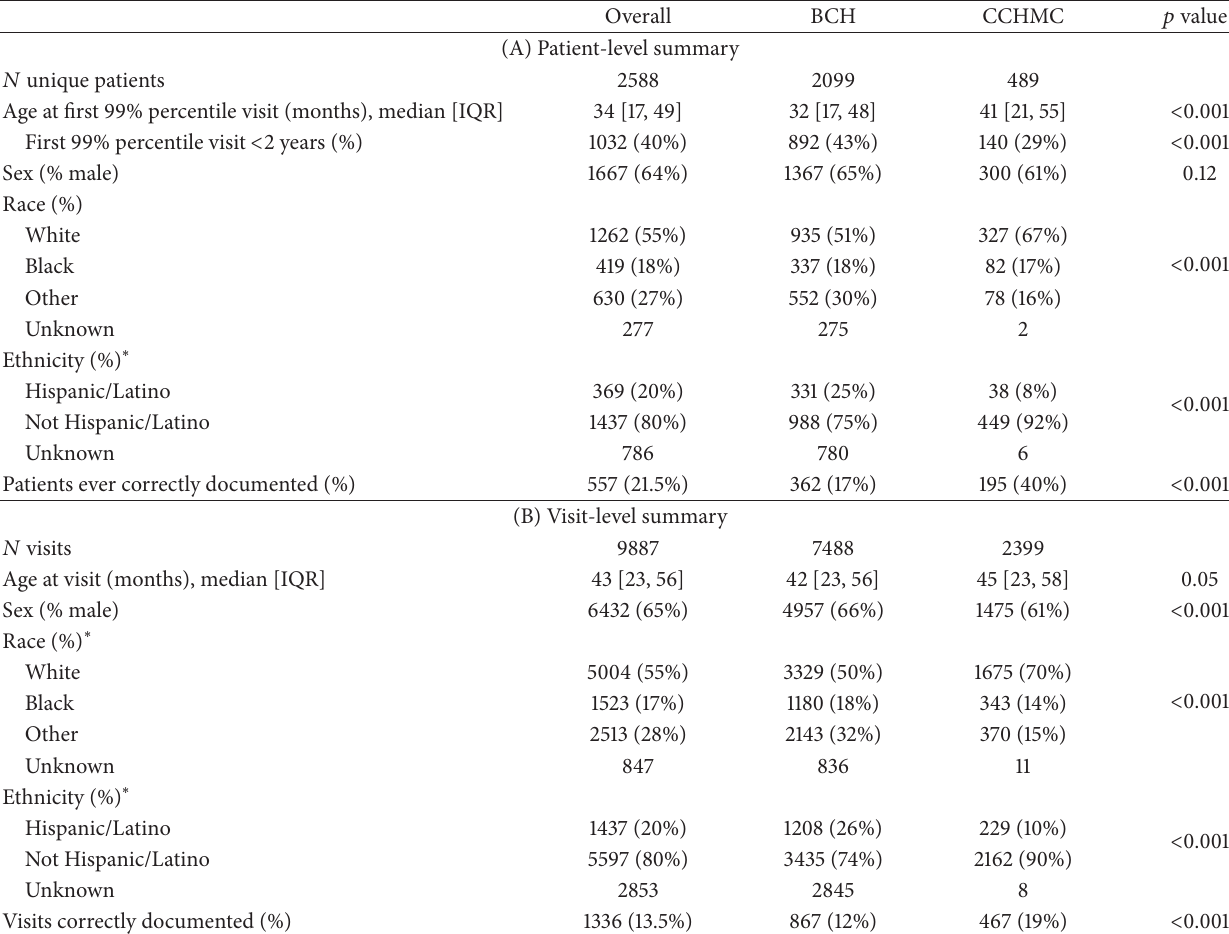
Table 3: Description of study